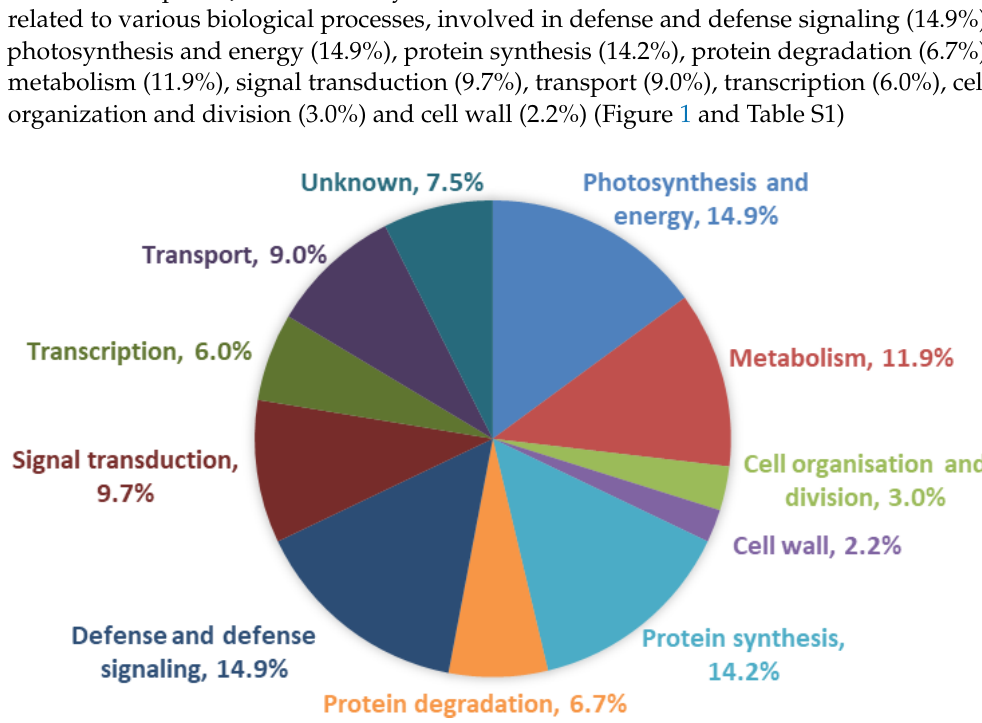
Figure 1. Functional classifications of SSH-derived ESTs homologous to known functional proteins.